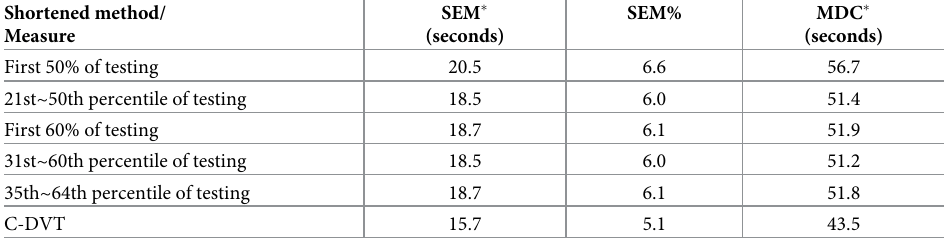
(cid:3) The scores used for calculating the SEM and MDC of the 5 segments were linearly transformed to be the same as those of the C-DVT. The SEM and MDC were calculated on the basis of ICC.